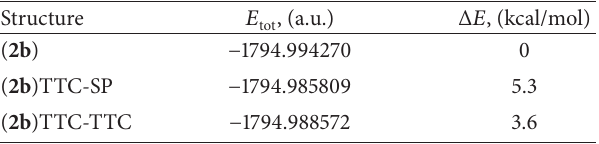
Table 2: Full energies including zero point energy (ZPE) correction 𝐸 + ZPE (a.u.) and relative energies Δ𝐸 (kcal/mol) of bis- tot spiropyran ( 2b ) and its open isomers calculated at the CPCM/PBE0/ 6-311G ∗∗ level of theory (acetonitrile